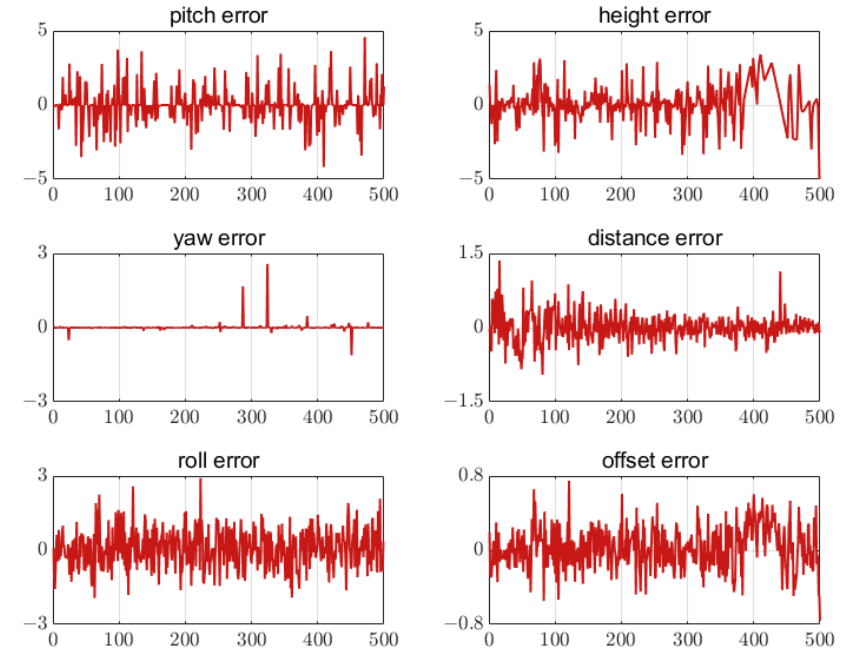
Figure 20. Error of seven feature points.The unit of the attitude error is degree. The unit of the position error is meter. The horizontal axis in all figures is the number of measurement points.